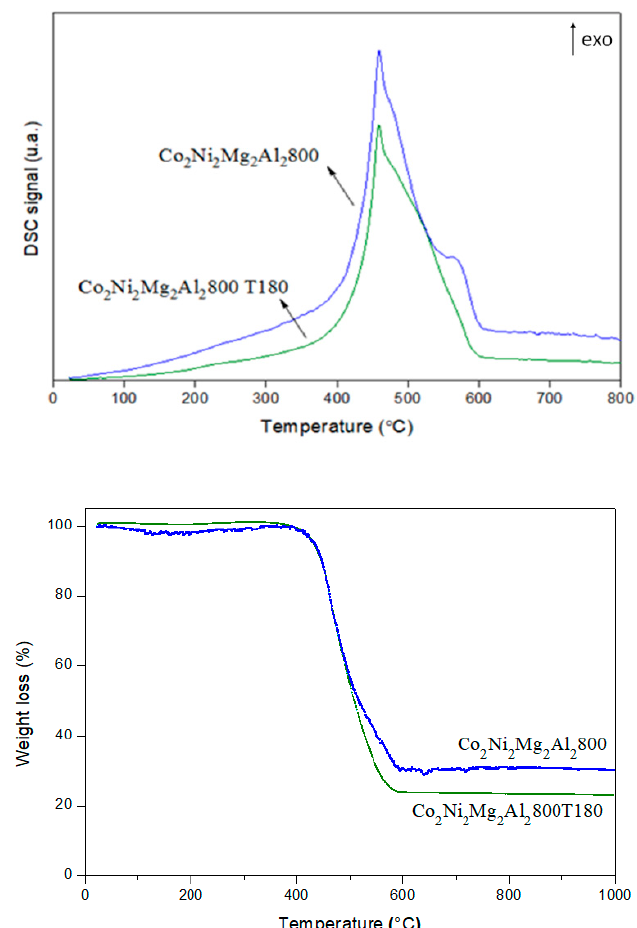
Figure 16. Thermal analysis of Co 2 Ni 2 Mg 2 Al 2 800 after the dry reforming of methane in the absence and the presence of 180 ppm of